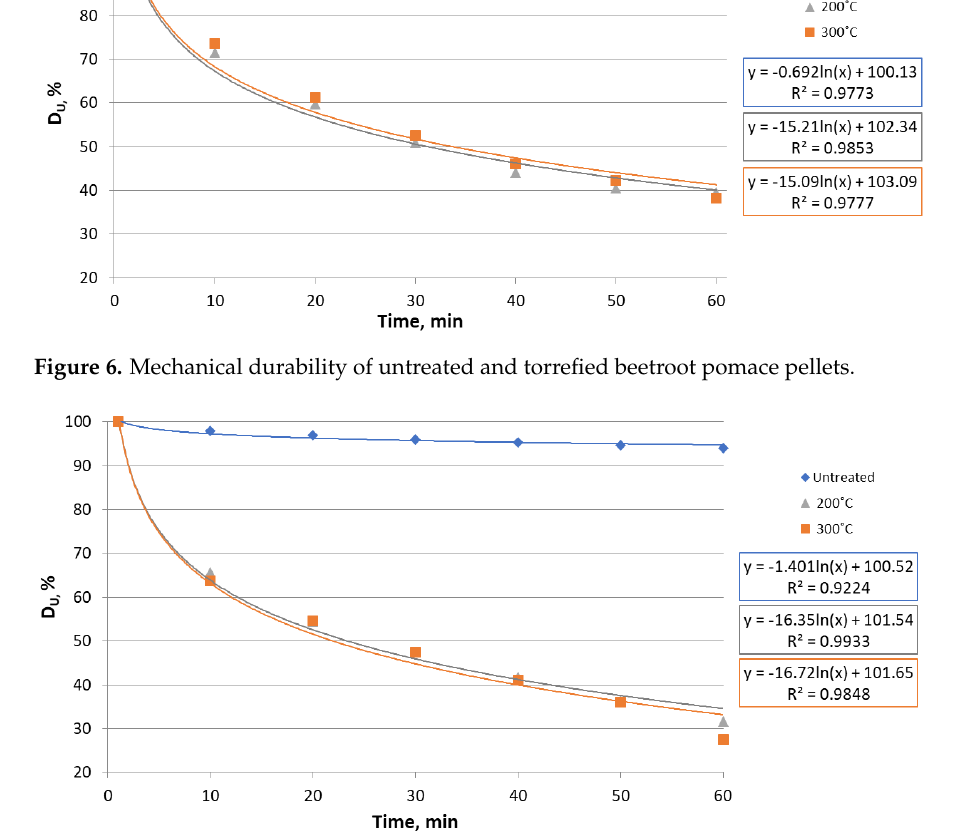
Figure 7. Mechanical durability of untreated and torrefied grass pellets.